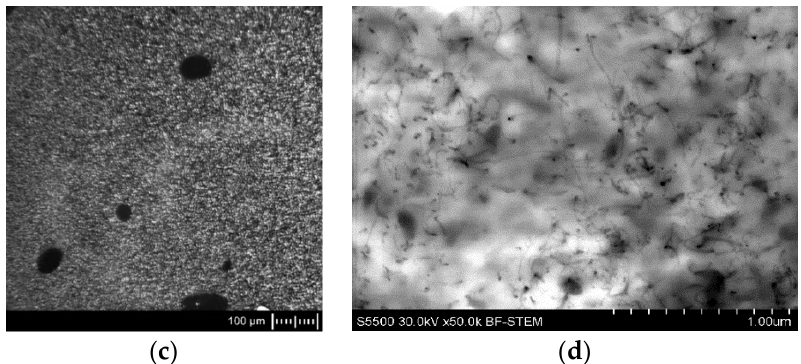
Figure 2. The dispersion of MWCNTs in the coPA: ( a ) macrodispersion in coPA + 5 wt% MWCNTs; ( b ) macrodispersion in coPA + 10 wt% MWCNTs; ( c ) dispersion in coPA + 5 wt% MWCNTs; ( d ) dispersion in coPA + 10 wt% MWCNTs. Scale: 100 µm ( a , c ) and 1 µm ( b , d ).